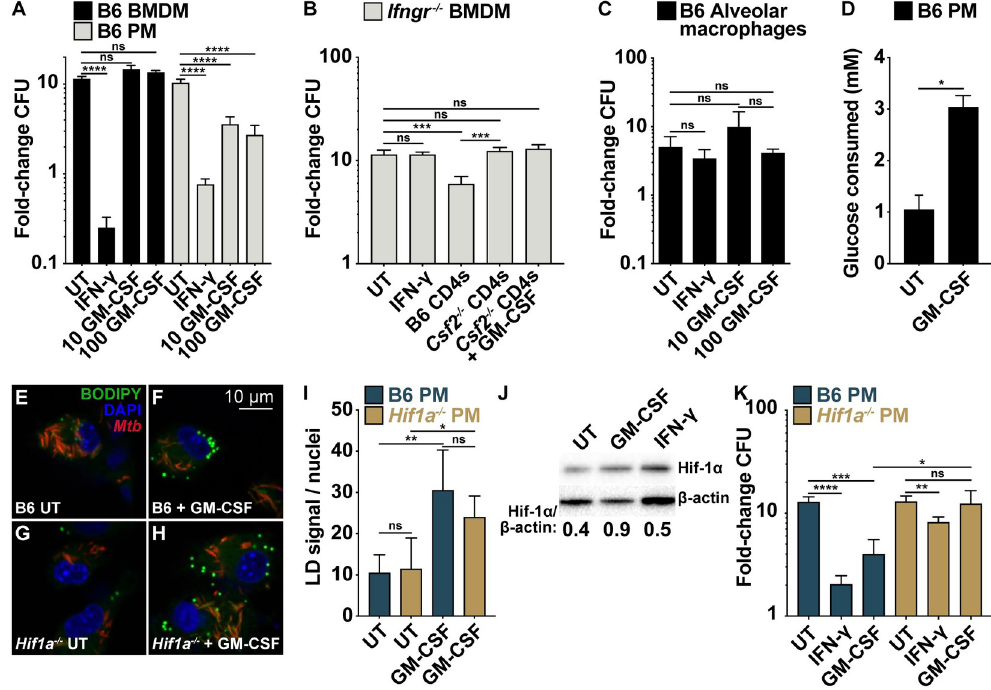
Fig 6. GM-CSF activates HIF-1 α to restrict M . tuberculosis in peritoneal macrophages. ( A ) CFU fold-change at d 4 postinfection for BMDMs and peritoneal macrophages treated with IFN- γ or 10 or 100 ng/mL GM-CSF. ( B ) CFU fold- change at d 5 postinfection for Ifngr -/- BMDMs co-cultured with wild-type or Csf2 -/- lung CD4 T cells and GM-CSF. ( C ) CFU fold-change at d 4 postinfection for alveolar macrophages treated with GM-CSF. ( D ) Glucose consumption at 24 h postinfection for peritoneal macrophages treated with GM-CSF. ( E )-( H ) Microscopy for host lipid droplets (LDs) at 24 h postinfection for wild-type or Hif1a -/- peritoneal macrophages treated with GM-CSF. ( I ) Quantification of (E)-(H) for LD signal per macrophage. ( J ) Western blot for HIF-1 α on cell lysates 20 h postinfection for peritoneal macrophages treated with GM-CSF. HIF-1 α / β -actinratio is indicated and was quantified using ImageJ. ( K ) CFU fold-change at d 4 postinfection for wild-type and Hif1a -/- peritoneal macrophages treated with GM-CSF. Figures are representative of two (E)-(J) or three or more (A)-(D), (K) experiments. Error bars are SD from four replicate samples (A)-(D), (K) or four replicate wells (I), � p < 0.05, �� p < 0.01, ��� p < 0.001, ���� p < 0.0001 by unpaired